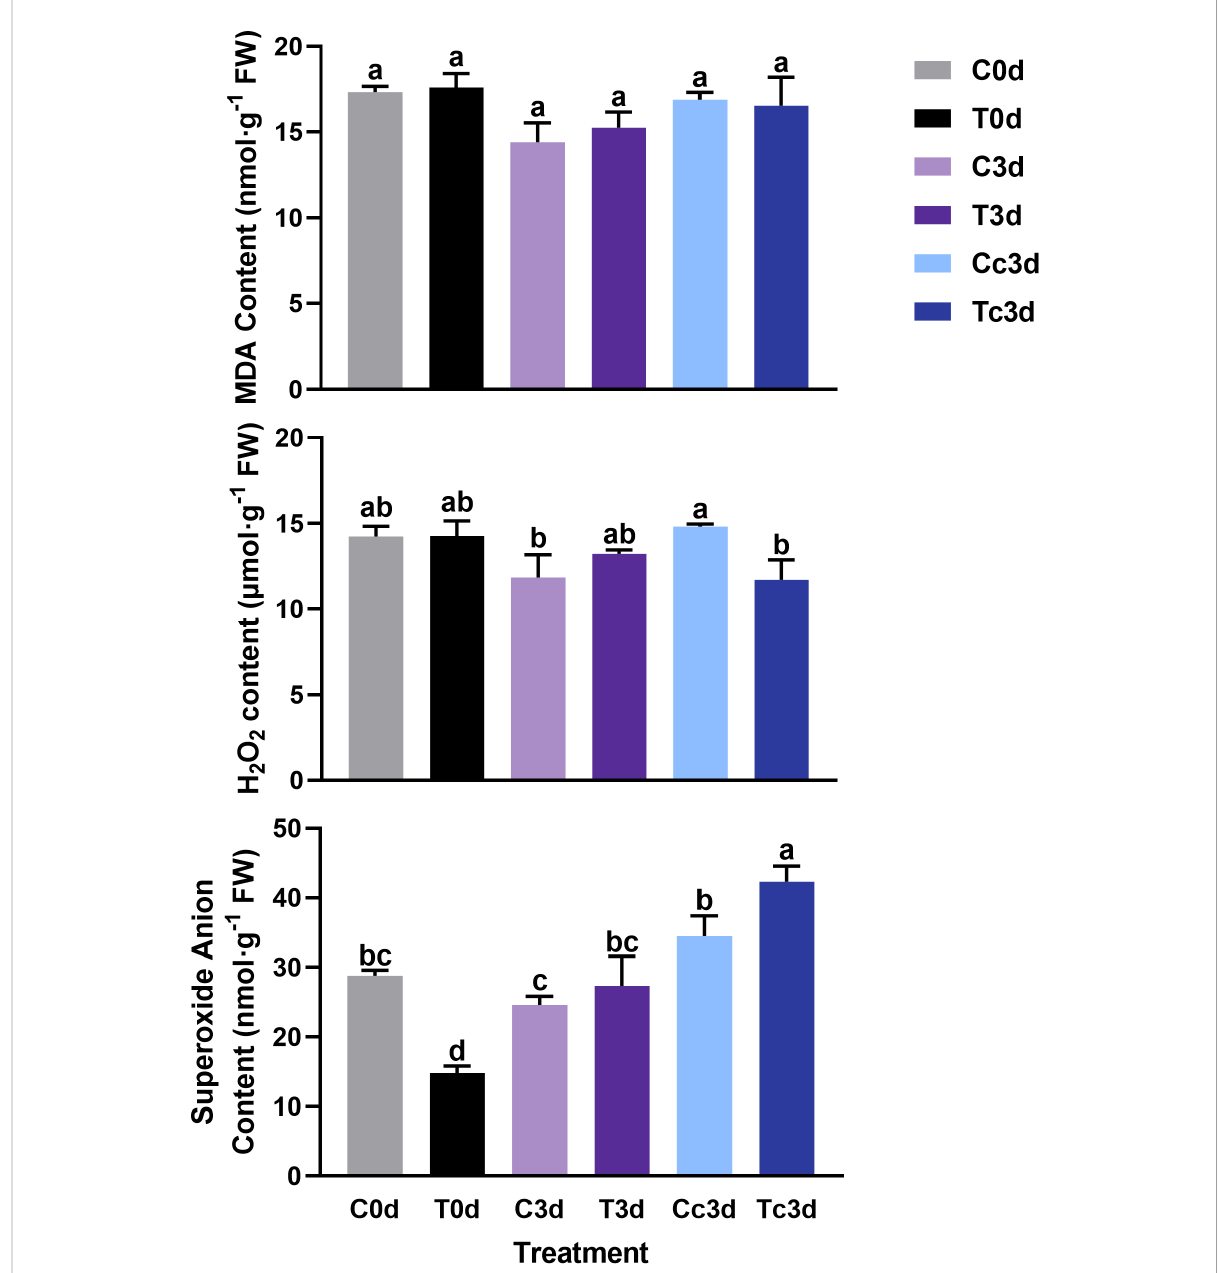
FIGURE 2 The effect of arbuscular mycorrhizal fungus and anthracnose pathogen on the indexes of active oxygen. H 2 O 2 : hydrogen peroxide; MDA: malondialdehyde. “ C, ” “ d, ” “ T, ” and “ c ” indicated “ non-mycorrhizal, ” “ days post infection, ” “ mycorrhizal, ” and “ Colletotrichum camelliae , ” respectively. In each column means with similar letters are not signi fi cantly different at p <